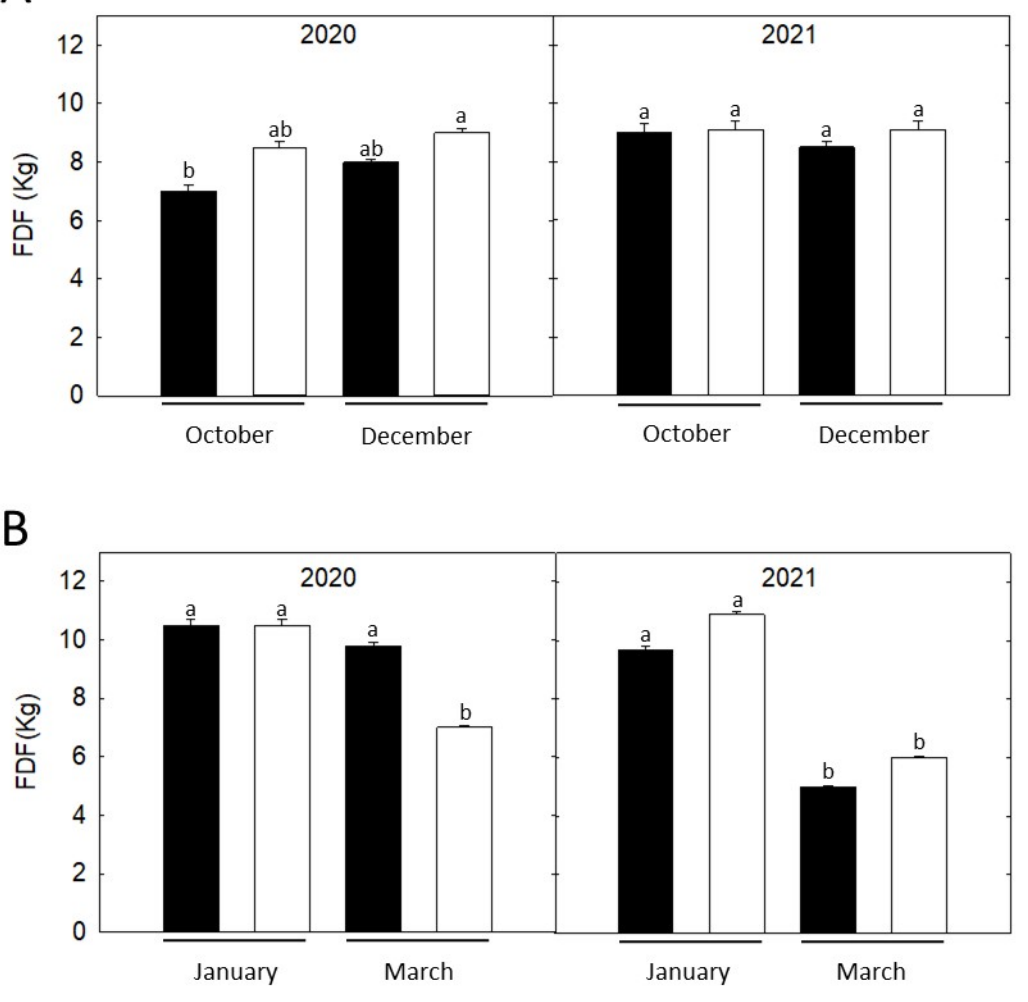
Figure 2. Fruit Detachment Force (FDF) in Hamlin ( A ) and Valencia ( B ) scions grafted on Swingle (■) and US-942 (□) rootstocks. Data are means of four biological replicates. Error bars represent standard errors. Means with the same letter are not significantly different from each other at p -value < 0.05 according to Tukey – Kramer.